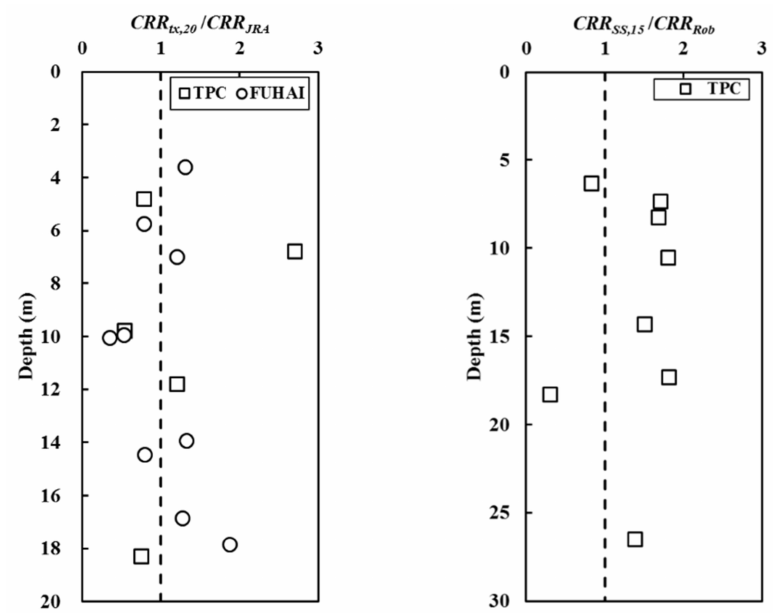
Figure 6. Comparing the results of cyclic laboratory test and simplified